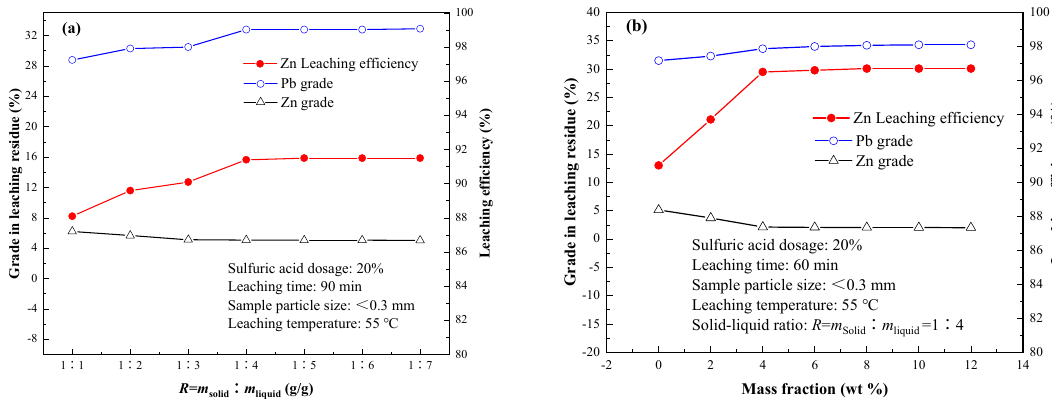
Figure 6. Effect of the solid-liquid ratio ( a ) and sulfurous acid dosage ( b ) on the leaching efficiency of zinc and the metal grades in the leaching residue.